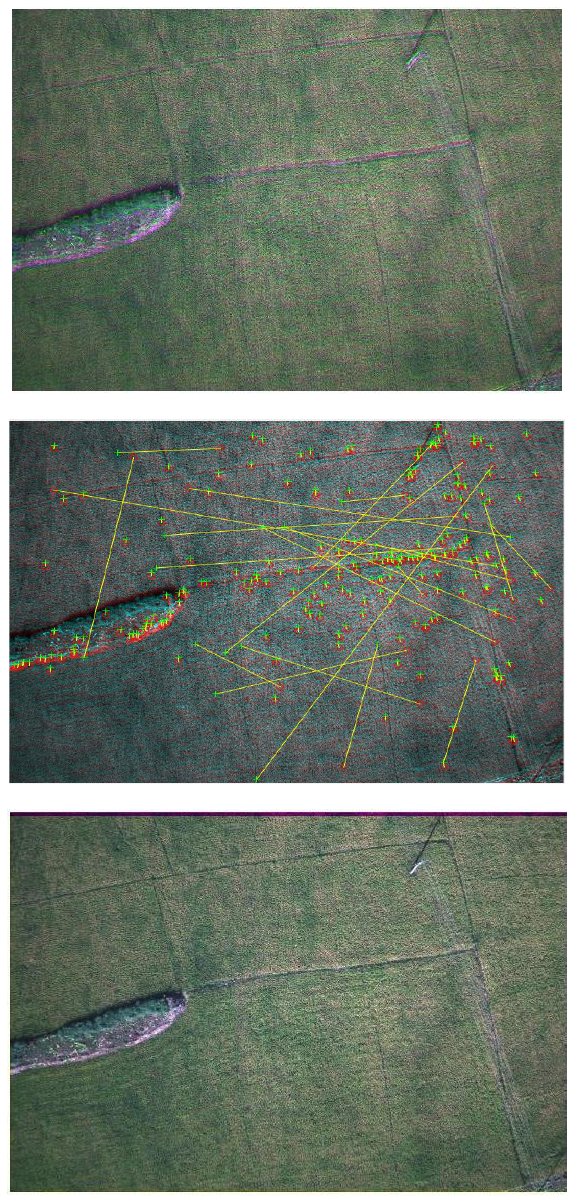
Figure 4. UAV multispectral image before (top) and after (bottom) registration.